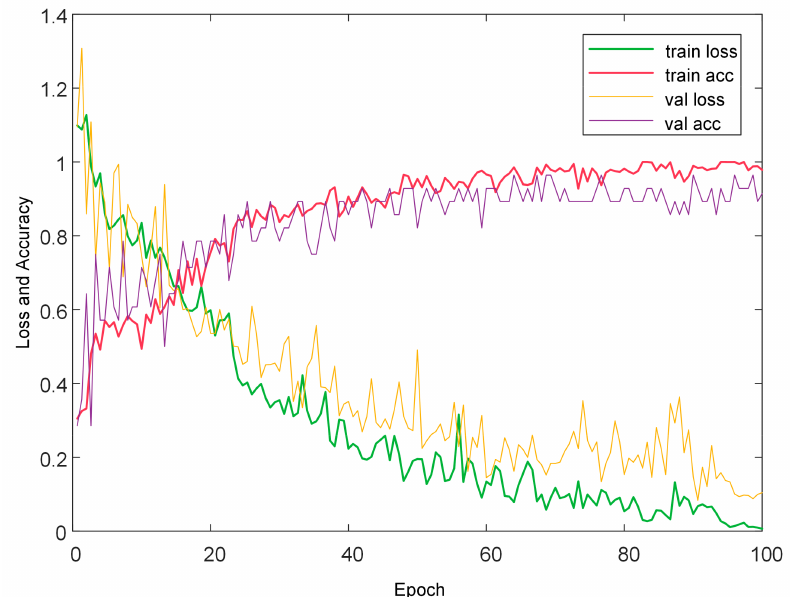
Figure 7. The accuracy and loss curves of 1D-CNN model without